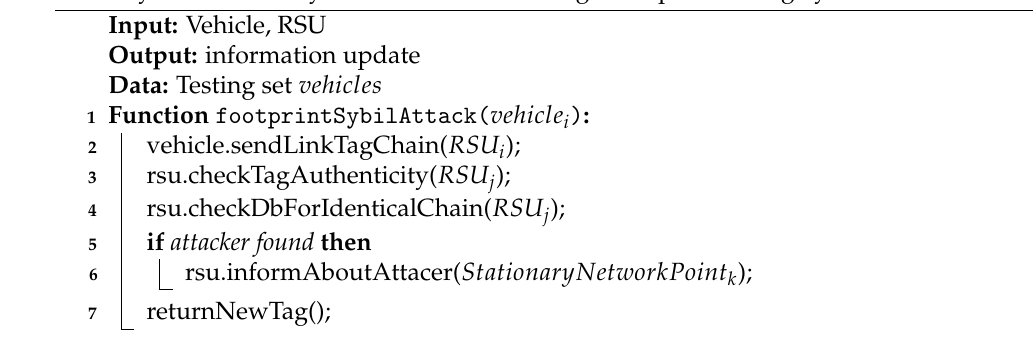
Algorithm 5: Communication between the vehicle and the RSU in order to certify its authenticity and receive the next tag—footprint during Sybil